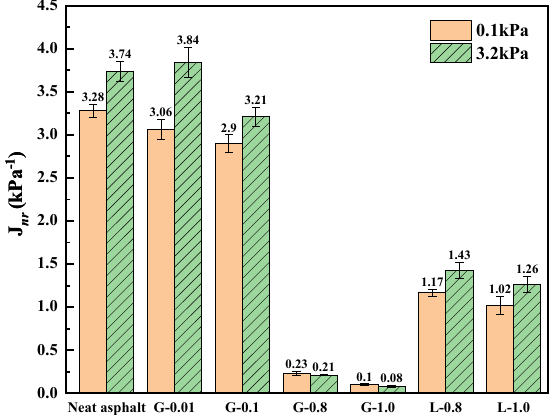
Figure 6. J nr of asphalts and mastics at 60 °C.